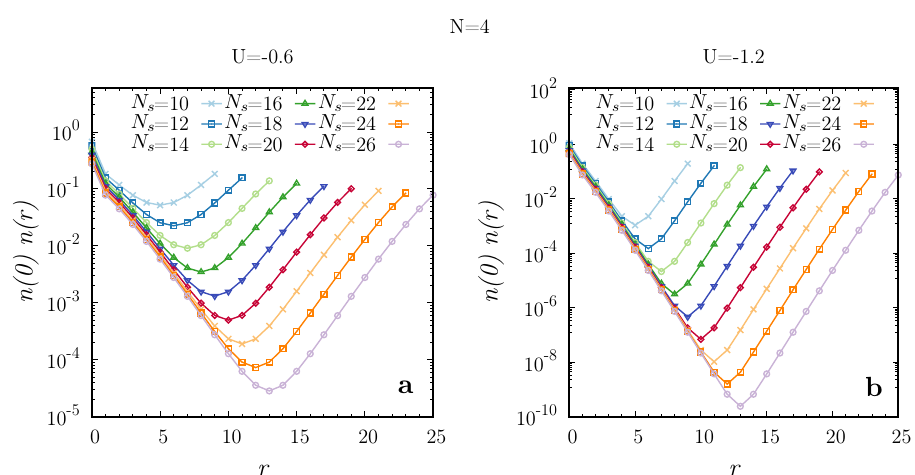
Figure 7: Density-density correlations C